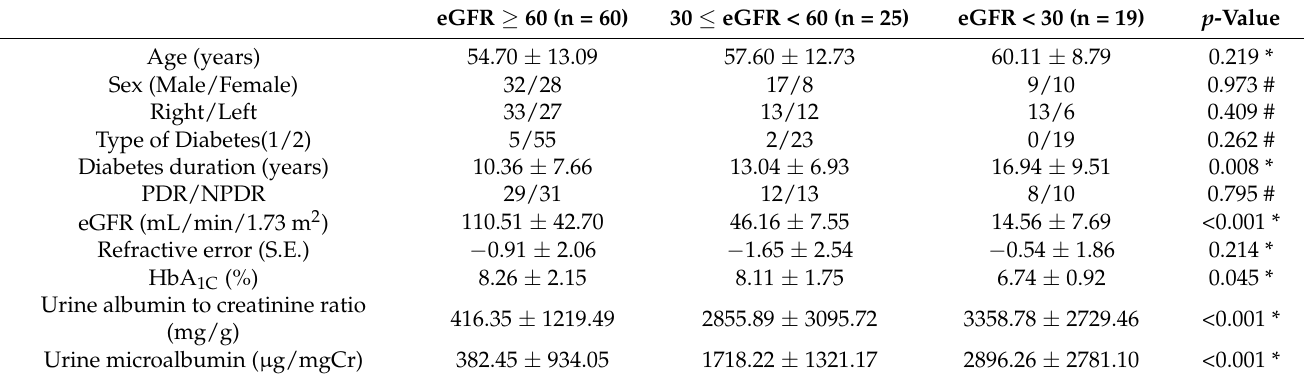
Table 1. Comparison of demographic data and baseline characteristics according to renal